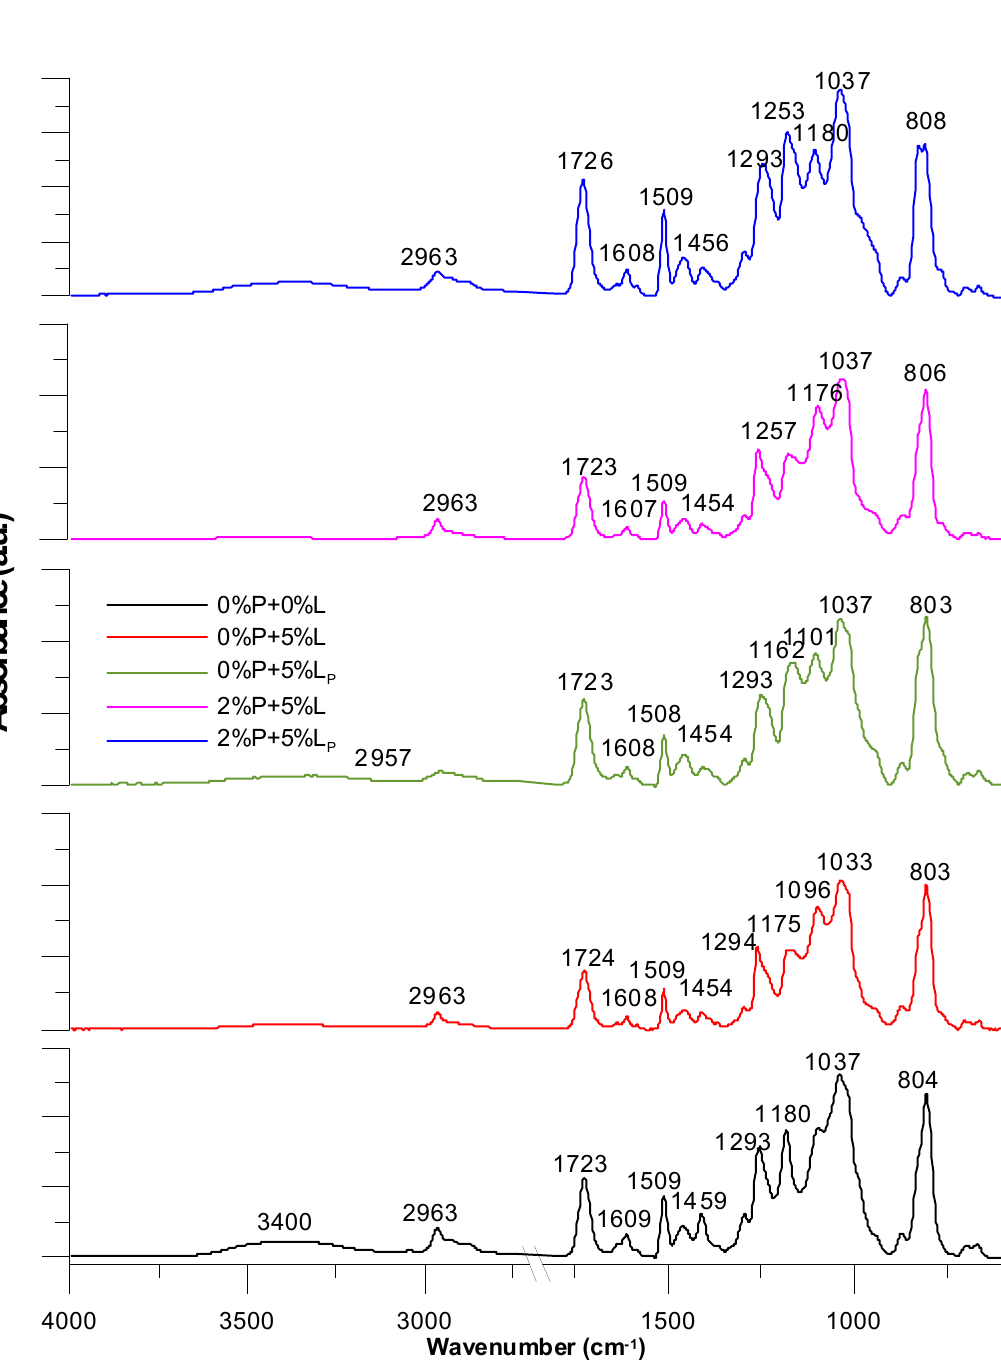
Figure 6. ATR-FTIR spectra of the studied composites. Table 1. Wavenumbers (1/cm) of characteristic bands visible in the Fourier transform infrared— attenuated total reflectance spectra.